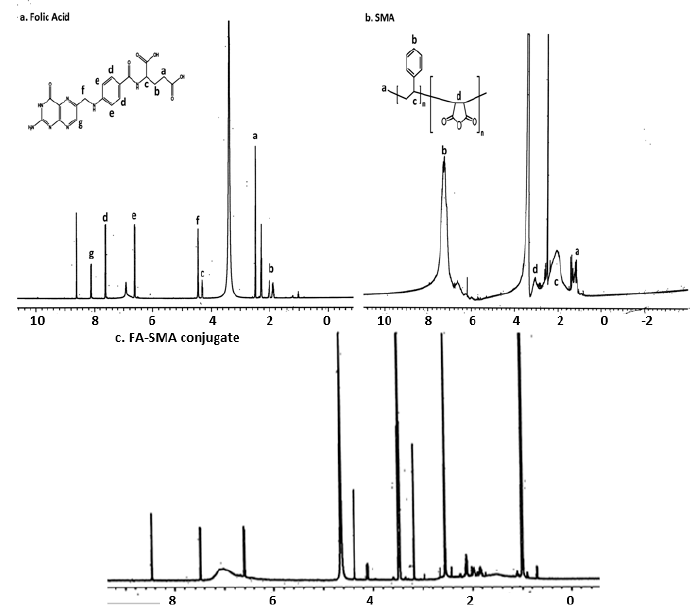
Figure 2. Cont. Figure 2.